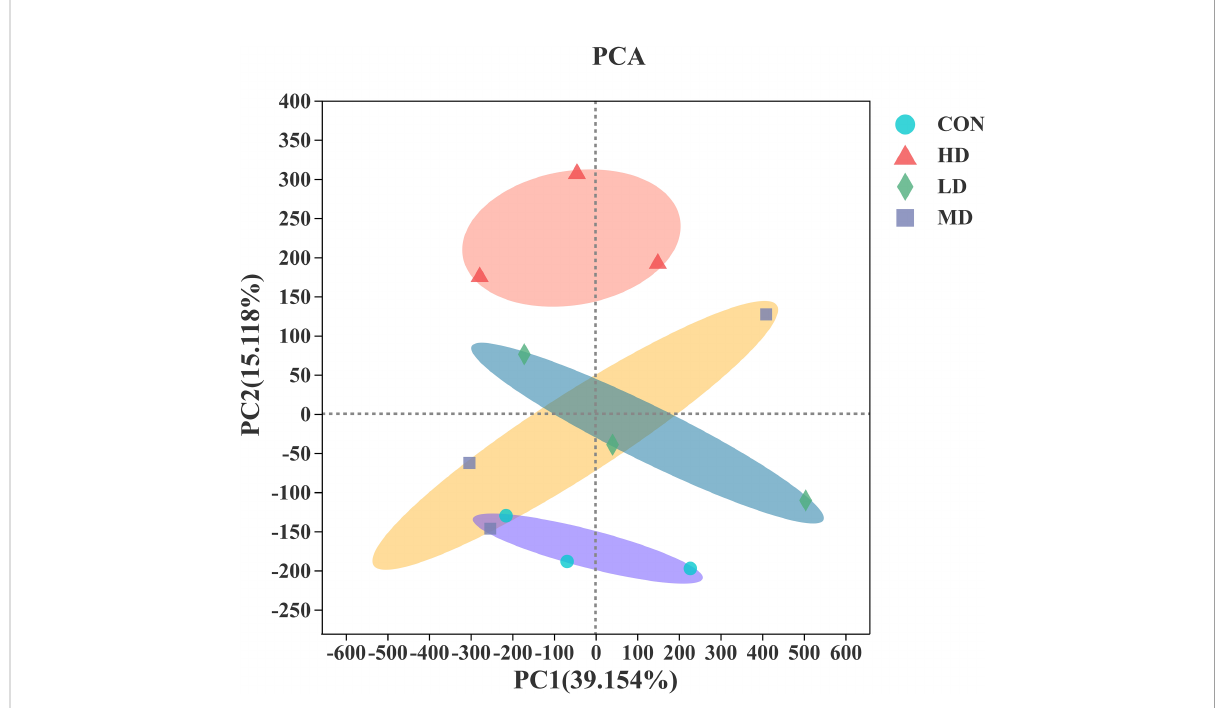
FIGURE 7 Principal component analysis (PCA) of the results based on the Bray-Curtis distance over all